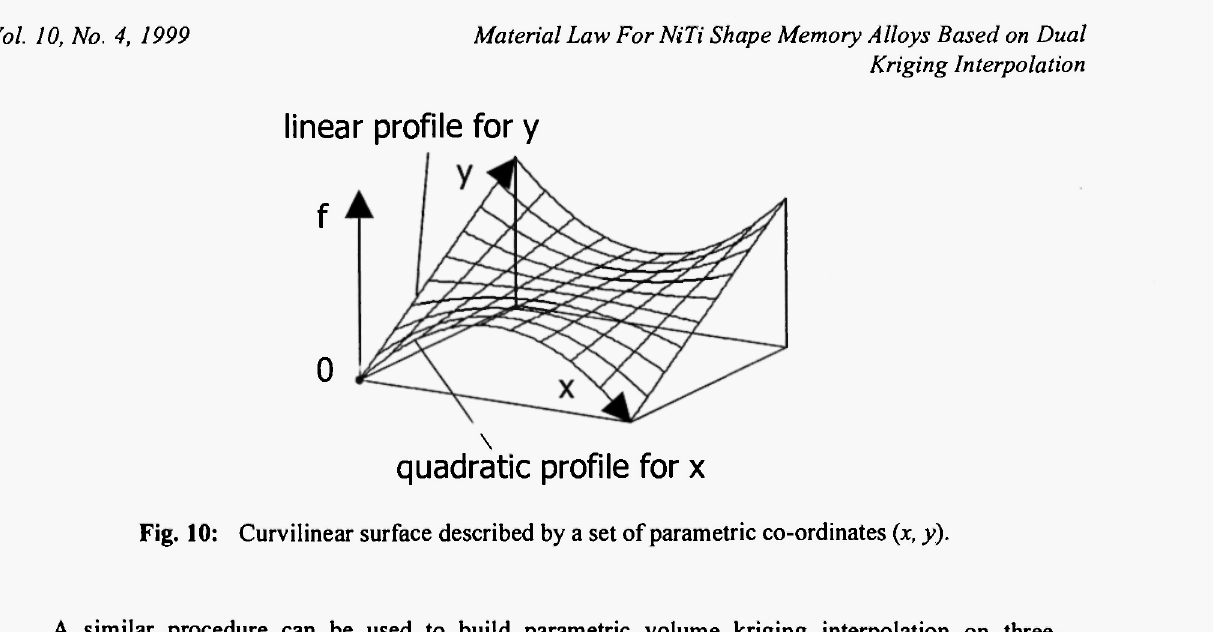
A similar procedure can be used to build parametric volume kriging interpolation on